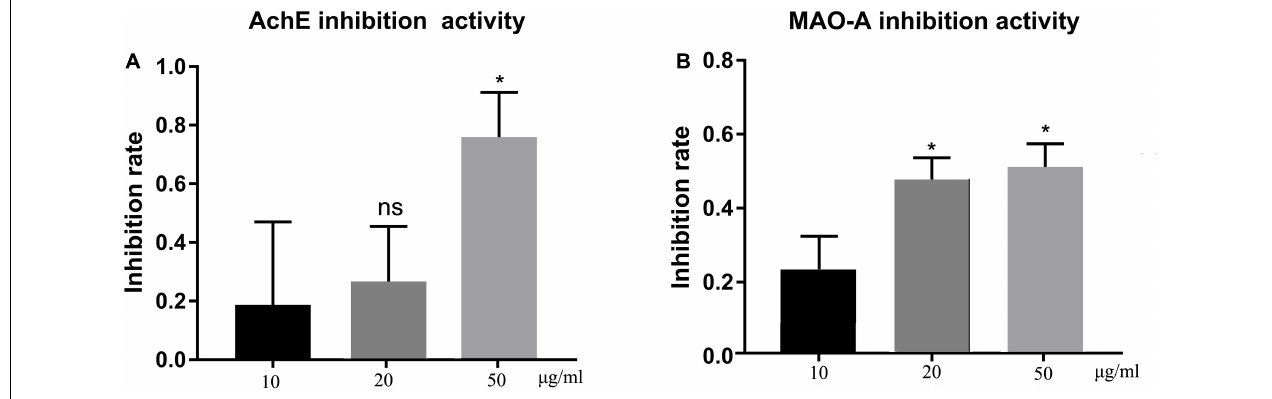
FIGURE 3 | In vitro AChE and MAO-A inhibitory activity of TFH. Results are represented as mean ± SEM of three independent replicates. ns, no significance; * p < 0.05 vs. the 10 µ g/ml group.